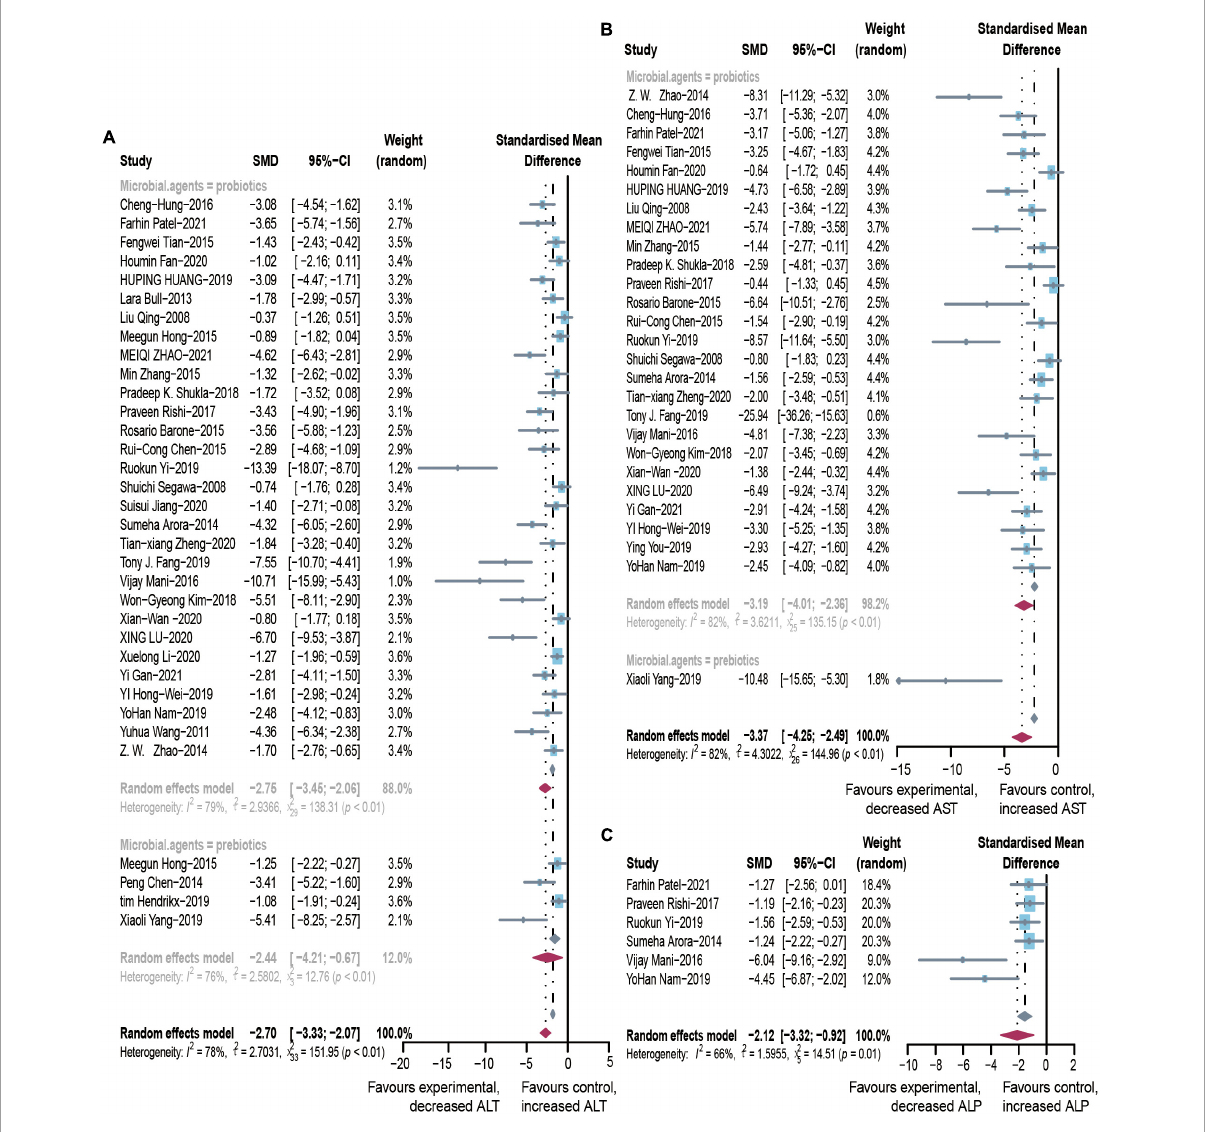
FIGURE4 Effectiveness of microbial agents on liver biochemical index. (A) The effect of microbial agents on ALT, (B) AST, and (C) ALP. SMD, Standardized mean difference; CI, Confidence